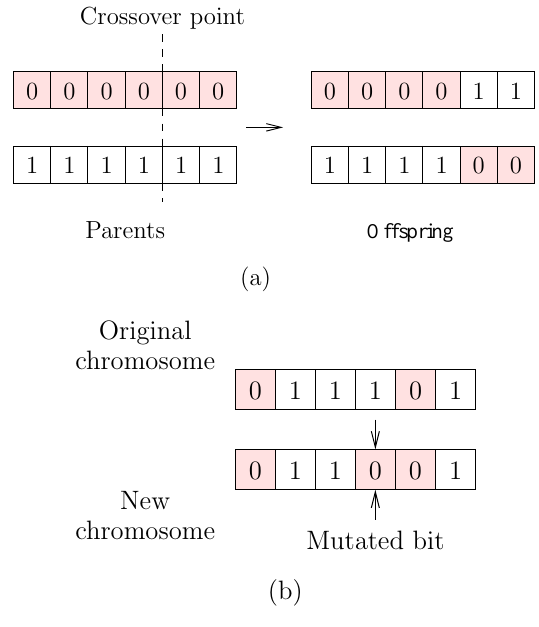
Fig. 3. Manipulation operations. ( a ) Crossover. ( b ) Mutation.